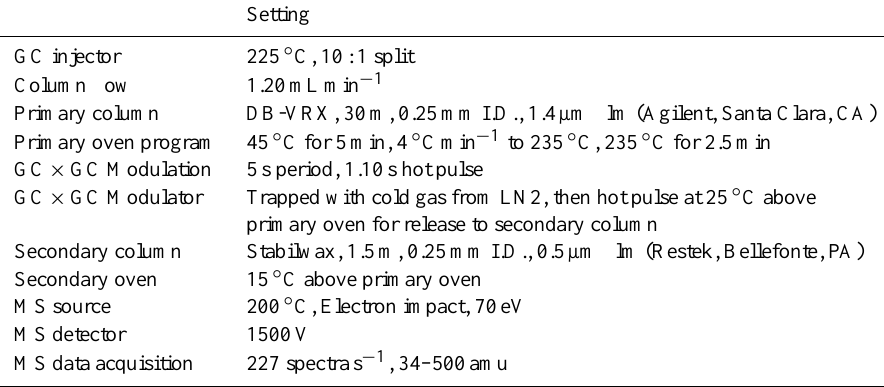
Table 1. GC × GC–ToFMS Conditions.